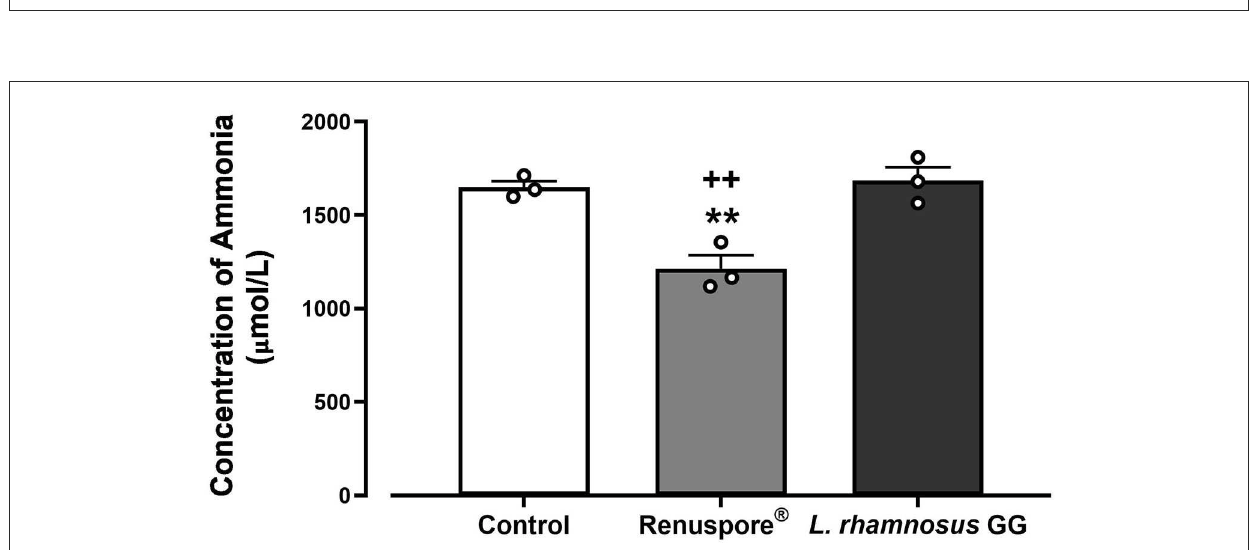
FIGURE5 Renuspore ® degraded ammonia significantly in supplemented minimal media when compared with the untreated control and L. rhamnosus GG. The results show an average concentration ( n = 3) ± standard error. The significance between Renuspore ® and control is indicated as ** p < 0.01, and the significance between Renuspore ® and L. rhamnosus GG is indicated as ++ p < 0.01. The results were statistically analyzed using the one-way analysis of variance (ANOVA) (biological replicates n = 3) followed by Tukey’s multiple comparison test using GraphPad Prism